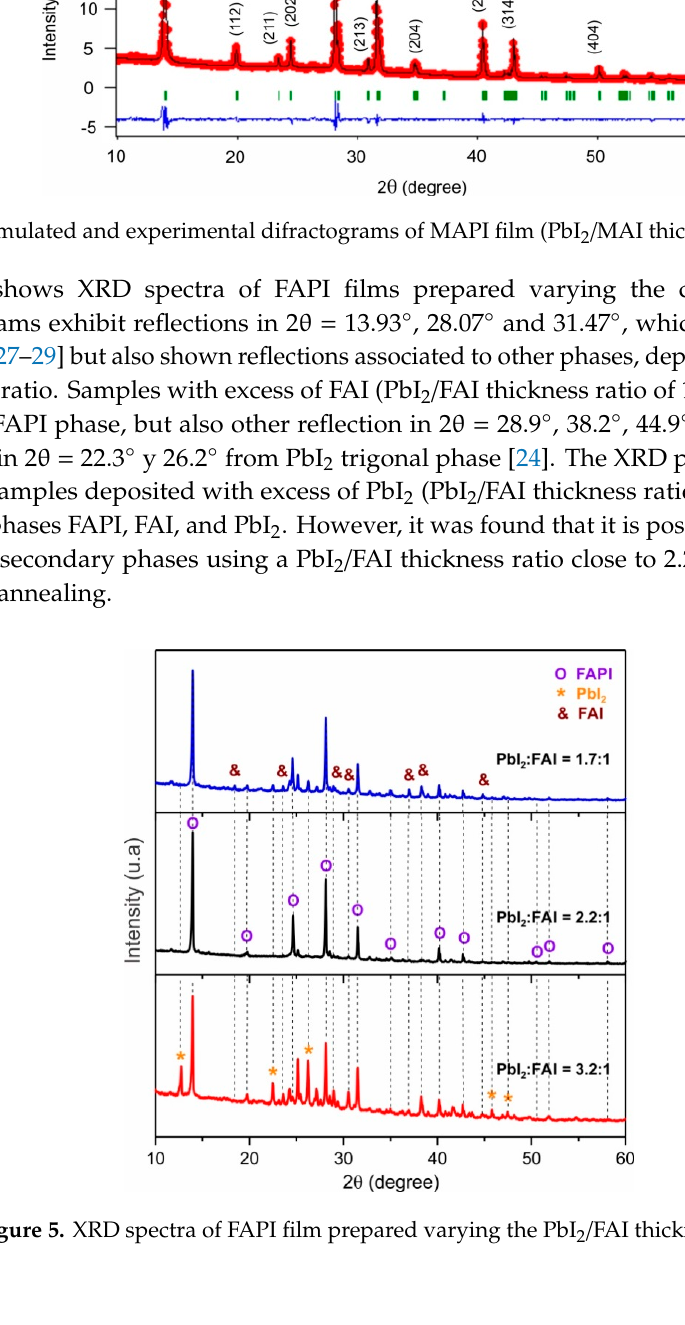
Figure 5. XRD spectra of FAPI film prepared varying the PbI 2 /FAI thickness ratio.